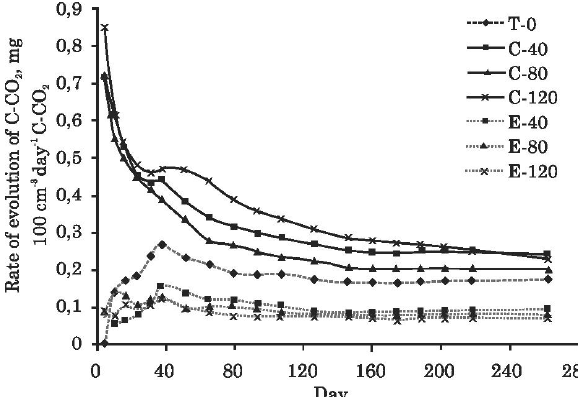
Figure 2. Rate of CO 2 emission, from columns treated with increasing doses of limestone and steel slag, during 262